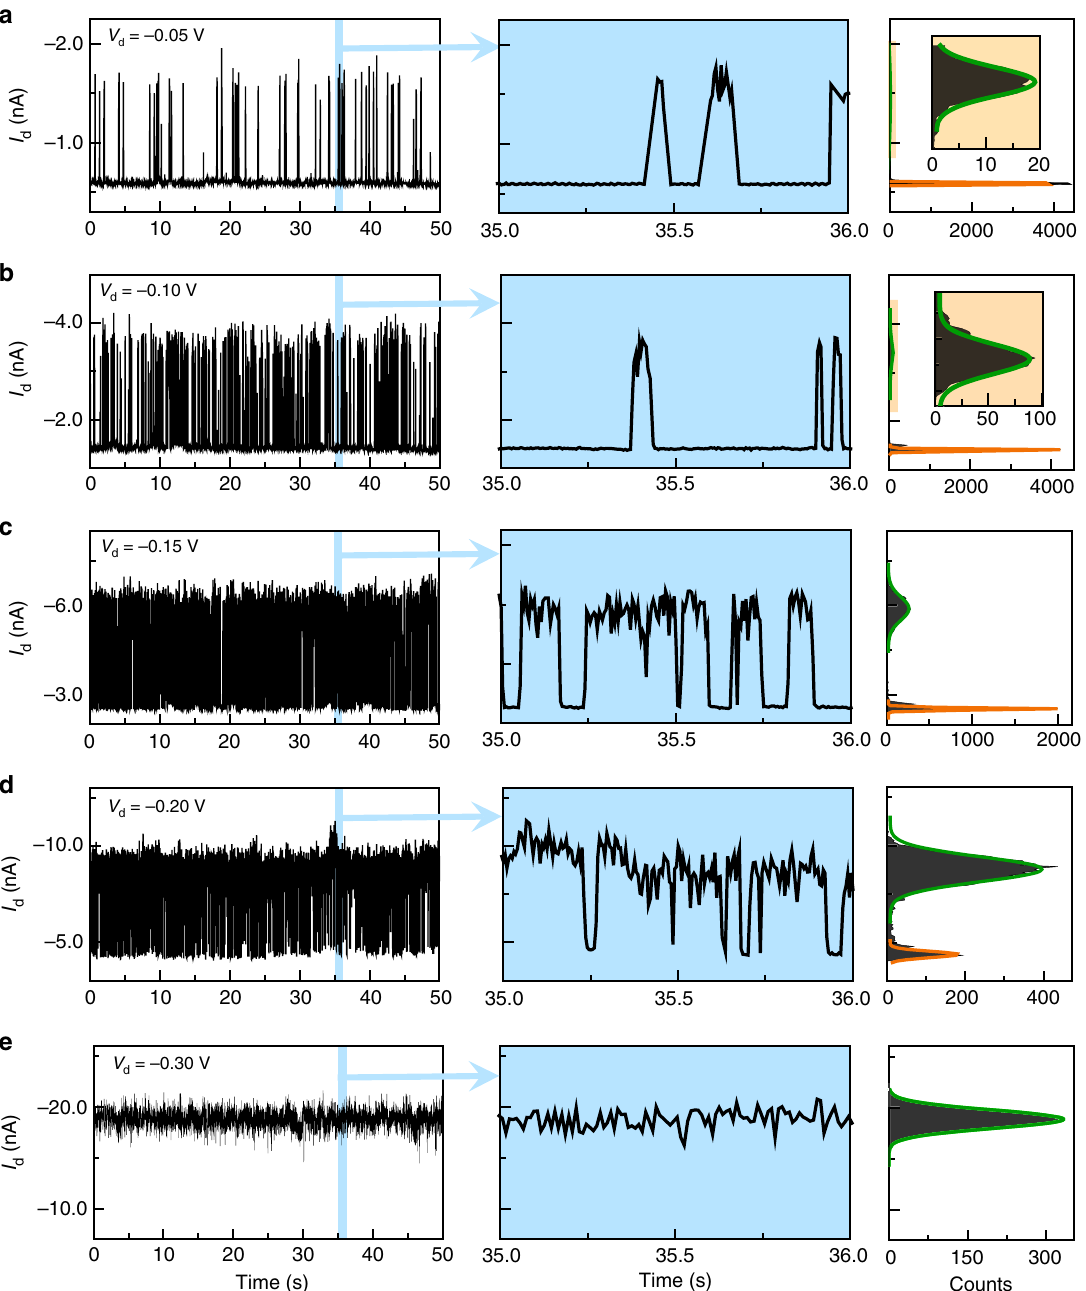
Fig. 3 Voltage dependence of stochastic switching. a – e I – t curves, corresponding enlarge I – t curves marked in blue, and corresponding histograms of a working GMG-SMJ device measured at different bias voltages: − 0.05 V ( a ), − 0.10 V ( b ), − 0.15 V ( c ), − 0.20 V ( d ), and − 0.30 V ( e ) at 160 K. Insets in the right column are the enlarged curves marked in yellow. The gate voltage is 0